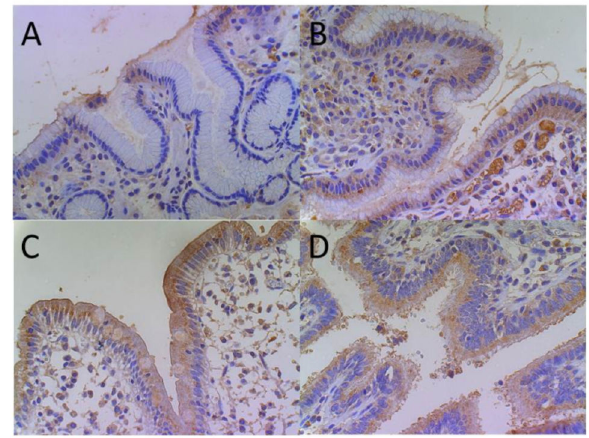
Figure 2. HBD2 immunostaining in H. pylori negative and positive mucosal antrum. HBD2 immunohistochemistry shows stronger cytoplasmic brown coloured staining in H. pylori positive (B) vs. negative (A) antrum. In Crohn’s colitis (C) and unspecific bronchiolitis (D) HBD2 peptide was also found in epithelial cytoplasm.